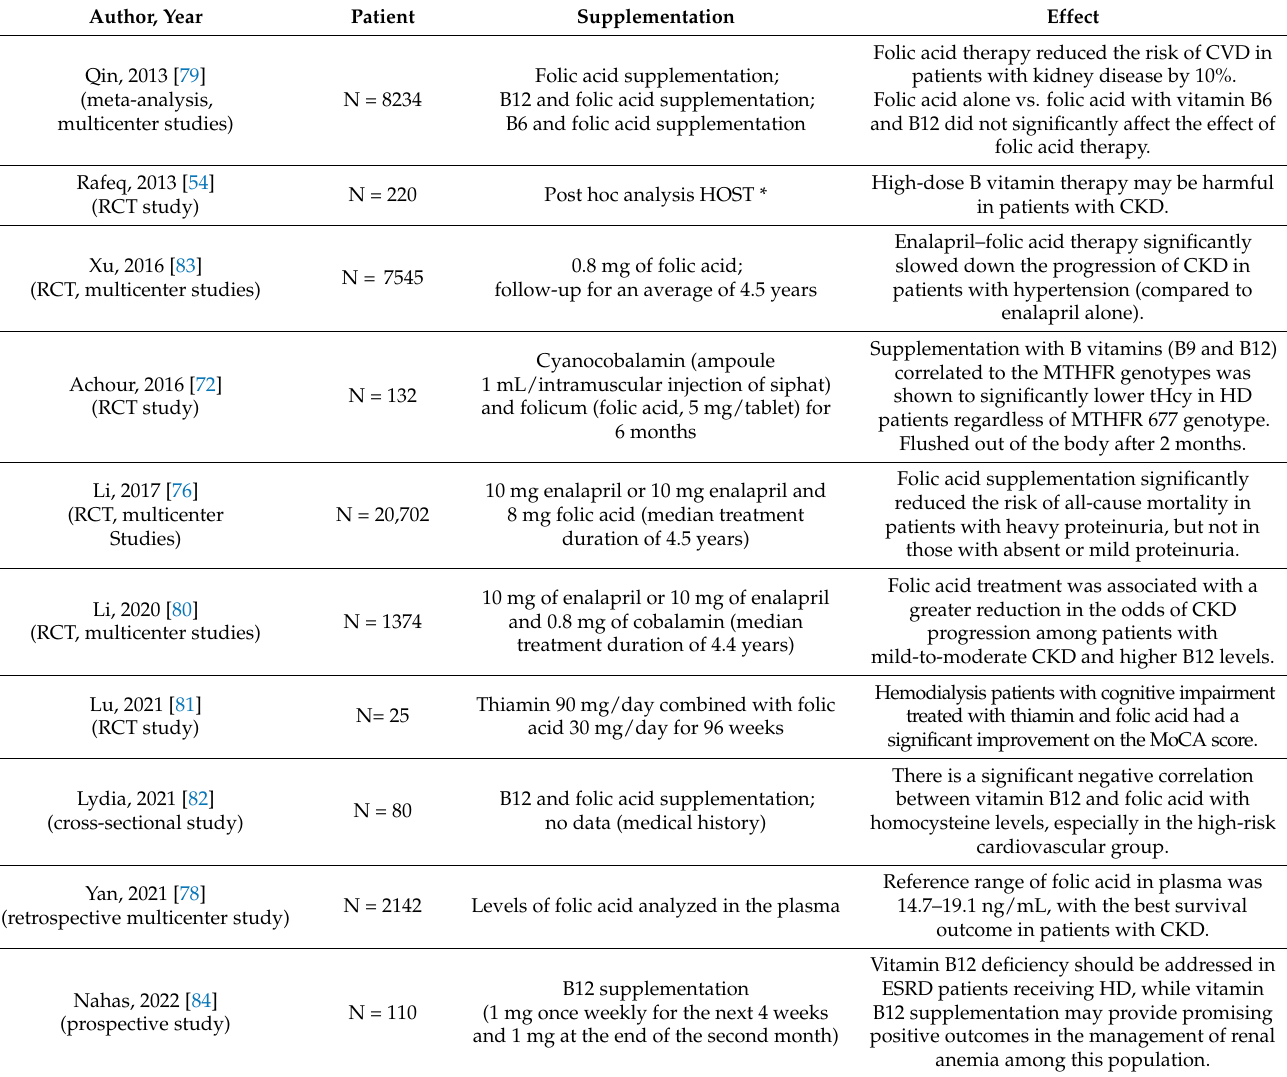
Table 2. Studies on folic acid and cobalamin supplementation in